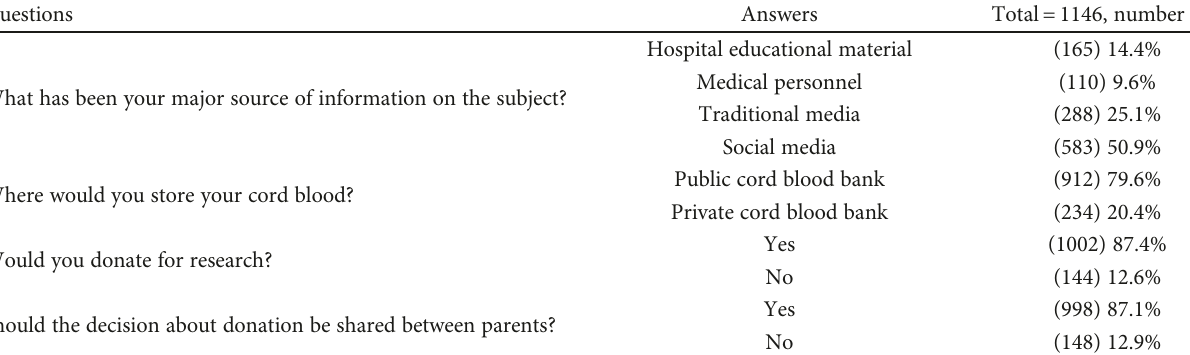
Table 4: Knowledge and attitude analysis towards cord blood